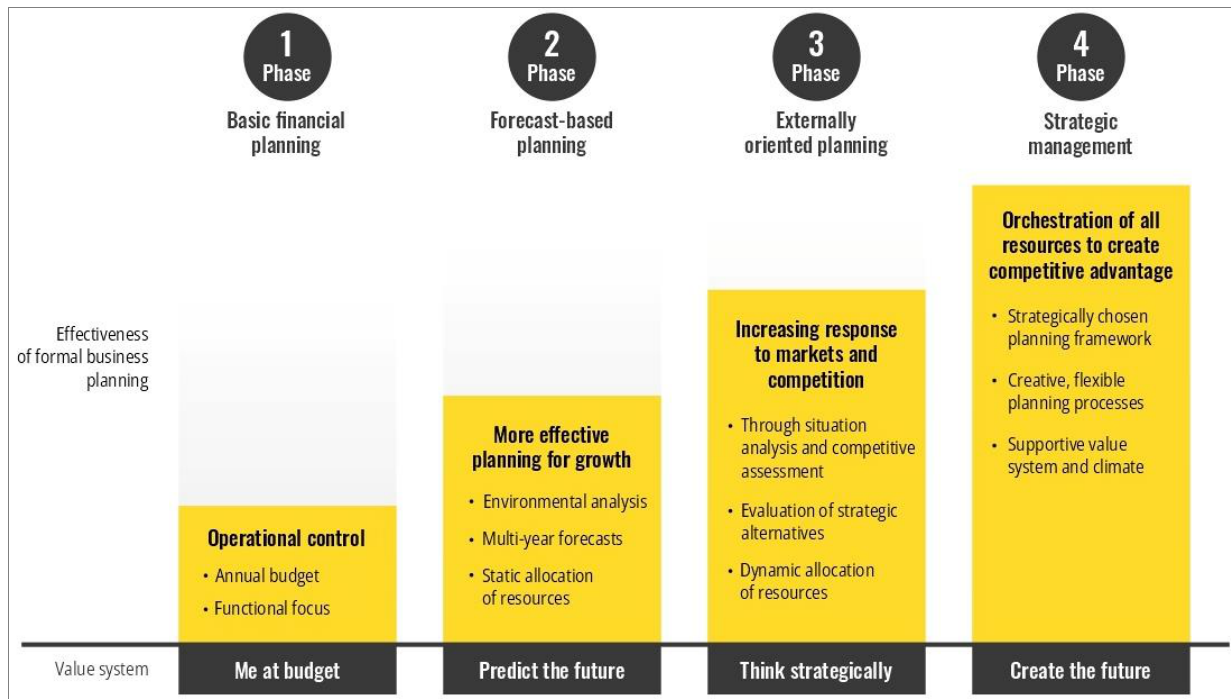
Figure 1. Four phases in the evolution of strategic and formal planning for achieving